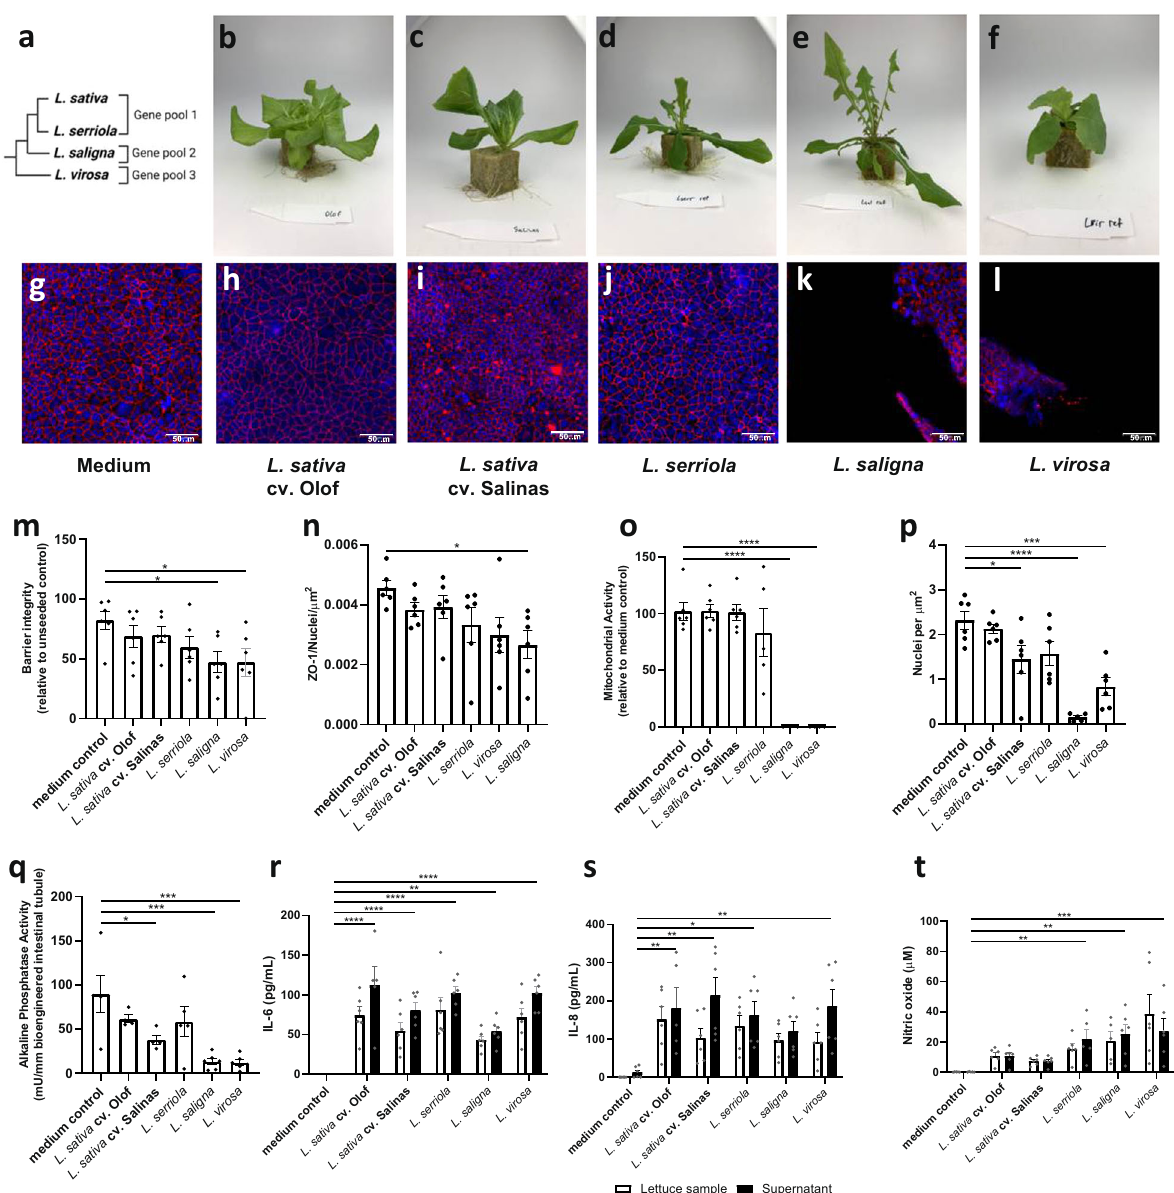
Fig. 3 Extracts from wild lettuce relatives L. saligna and L. virosa reduce epithelial integrity and cell viability in the bioengineered intestinal tubule. a Schematic of the phylogenetic tree for Lactuca species. L. sativa and wild progenitor belong to gene pool 1, while L. saligna and L. virosa are from pools 2 and 3, respectively. Representative photographs of 2.5 – 3-week-old plants of b L. sativa cv. Olof, c L. sativa cv. Salinas, d L. serriola US96UC23, e L. saligna CGN05271, f L. virosa CGN04683 used in the study. (G-L) Representative immuno fl uorescent images of nuclei (blue) and zonula occludens-1 (ZO-1, red) on intestinal tubule after exposure to medium (control) or extracts of L. sativa cv. Salinas and L. sativa cv. Olof, L. serriola , L. saligna , and L. virosa , respectively. m , n The intestinal epithelial barrier integrity is assessed via inulin-FITC permeability m and ZO-1 quanti fi cation n . Inulin-FITC permeability data are shown relative to the negative control, and ZO-1 quanti fi cation data are corrected for surface area and the number of nuclei. o Mitochondrial activity as a measure of cell viability after exposure to Lactuca extracts. Data are shown relative to medium control. p The number of nuclei corrected for the surface area as a measure of cell attachment. q Brush border enzyme activity of alkaline phosphatase, a common Caco-2 enterocyte differentiation marker. r – t Amounts of the secreted immune markers interleukin (IL)-6, IL-8, and nitric oxide (NO), respectively. White bars represent basal levels in the Lactuca extracts, whereas black bars visualize the concentration in the supernatant after 24 h of cellular exposure. Data are presented as mean ± SEM of n = 6 independent experiments. Data were corrected for outliers (1 outlier of 402 data points) and tested for signi fi cance using a t-test and one-way ANOVA. * p < 0.05, ** p < 0.005, *** p < 0.001 and **** p < 0.0001. Scale bar is 50